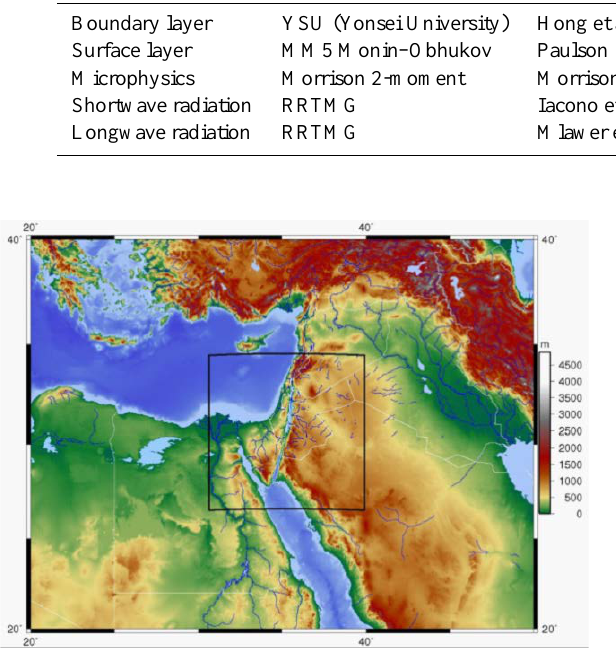
Fig. 5. Topographic map of the region of interest, at the eastern end of the Mediterranean. The model domain (approx. 888 × 888km) is marked in the centre with a black